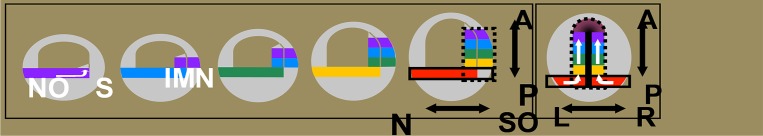
The time space translation hypothesis. Timed interactions between the Hox expressing non-organizer mesoderm (NO/N) and the Spemann organizer (S/SO) generate positional information during vertebrate gastrulation (Wacker et al., 2004; Jansen et al., 2007). Expression of new Hox genes (different colors) is initiated in non-organizer mesoderm (NO) at different times. Non-organizer mesodermal tissue moves toward the Spemann organizer by convergence and then extends anteriorly (arrow). When mesoderm adjacent to the Spemann organizer involutes (lM), the current Hox code is transferred to overlying neurectoderm (N). While the early Hox sequence in the non-organizer mesoderm (solid outlined black box) is running, new cells from this region are continuously moved into the range of Spemann organizer (dashed black box) and their Hox code is then stabilized by an organizer signal. Thus, the temporal Hox sequence is converted into a spatial AP pattern by continuous morphogenetic movement and stabilization of timed information by the organizer in both involuted mesoderm (IM) and overlying neurectoderm (N). The SO is shown only in the last drawing, as the heavy median black line. By this stage, it has become the notochord and a head mesodermal portion. The first five drawings represent paraxial profiles, where the organizer is not visible. The last drawing shows the dorsal side. The black dotted line in the last drawing depicts the sphere of influence of the SO. N, neurectoderm, NO/N, non-organizer mesoderm; S/SO, Spemann organizer; A, Anterior; P, Posterior; L, Left; R, Right. The white arrows reflect directions of cell movement flow.